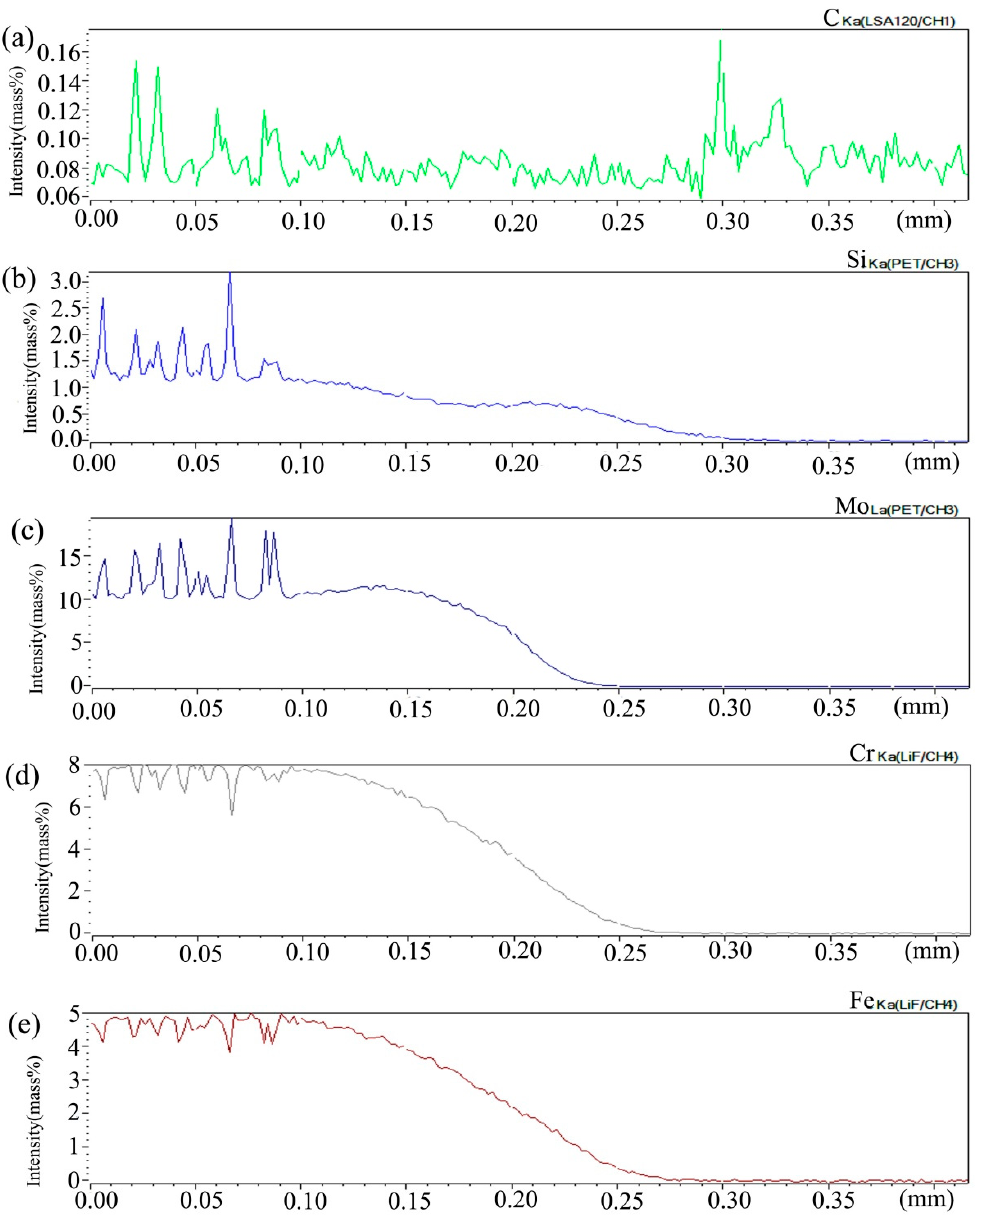
Figure 15. Composition distribution curve of the diffusion couple sample of 2Si alloy and pure nickel after 1000 °C/200 h heat treatment: ( a ) C, ( b ) Si, ( c ) Mo, ( d ) Cr, and ( e ) Fe. (The horizontal coordinate of the figures is the scanning distance and the vertical coordinate is element signal intensity, the zero position is the starting point of scanning).